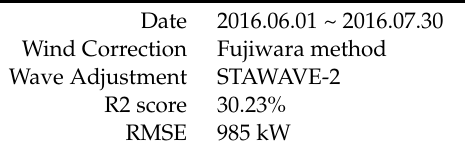
Table 4. Comparison with ISO15016